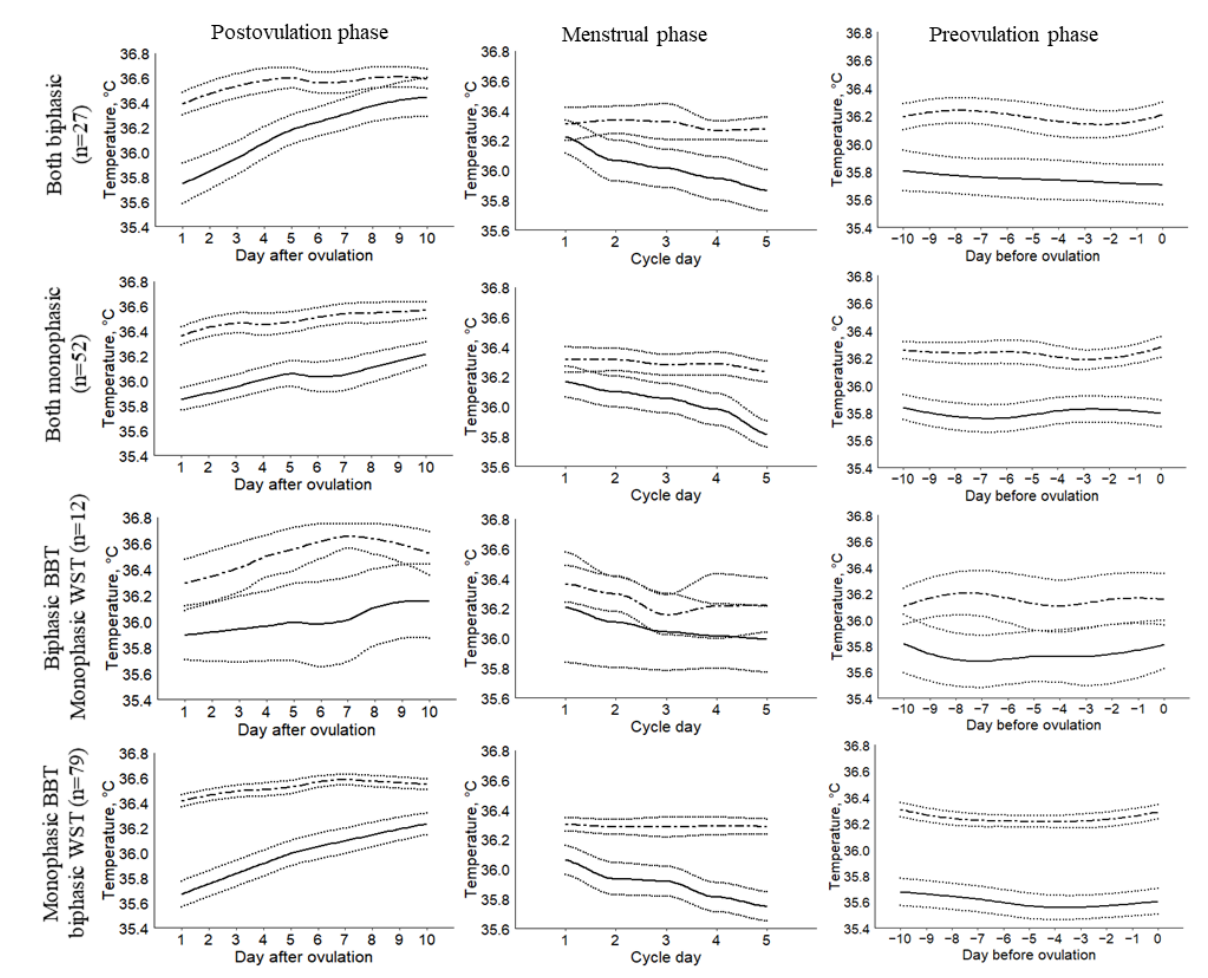
Figure 4. Smoothed temperature curves according to phases and patterns. Solid and dotted lines represent wrist skin temperature and 95% CIs, respectively; dashed and dotted lines represent basal body temperature and 95% CIs, respectively. BBT: basal body temperature; WST: wrist skin